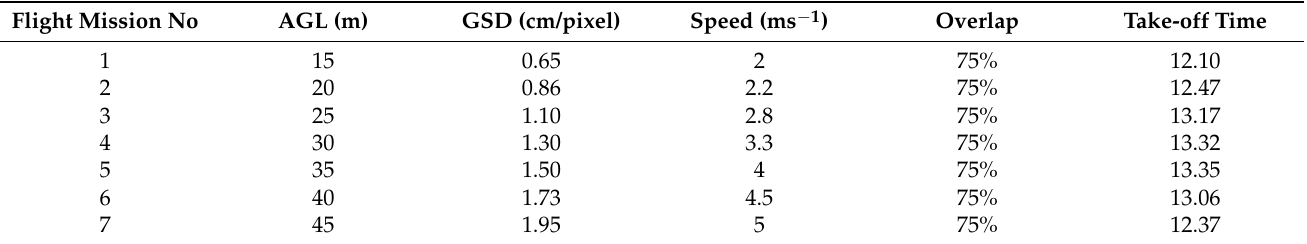
Table 2. Summary of multispectral flight mission data acquired at Sawdon Station hawkweed study site on 30 January 2021.